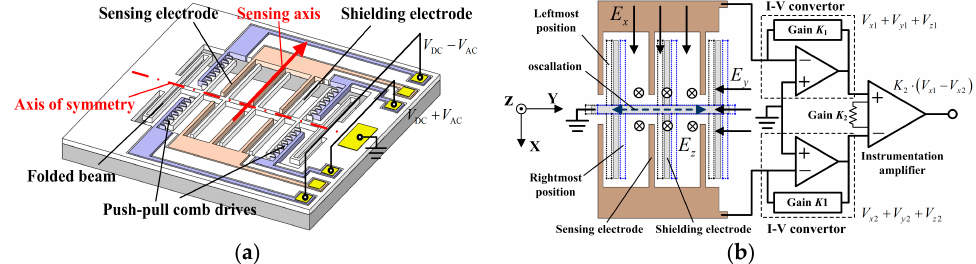
Figure 1. Schematic view of the proposed one-dimensional (1D) electric field sensor chip (EFSC). ( a ) The 1D EFSC is designed to be symmetrical, and its sensing axis is along symmetrical structures. V DC is the direct current (DC) bias voltage of driving signal, and V AC is alternating current (AC) voltage of driving signal; ( b ) two arrays of fixed sensing electrodes are connected to the difference circuit. E x , E y , and E z are the X -, Y - and Z -axis electric field components, respectively. V x , V y and V z are the outputs of sensing electrodes array with respect to E x , E y and E z after the I-V converter. In contrast to typical 1D EFSCs designed for sensing electric field components perpendicular to the chip, the proposed 1D EFSC focuses on sensing parallel electric field along symmetrical structures. The 1D EFSC is assumed to be placed on the X - Y plane with its sensing axis parallel to the X -axis, and its axis of symmetry located on Y - Z plane and parallel with the Y -axis, as shown in Figure 1b. A uniform